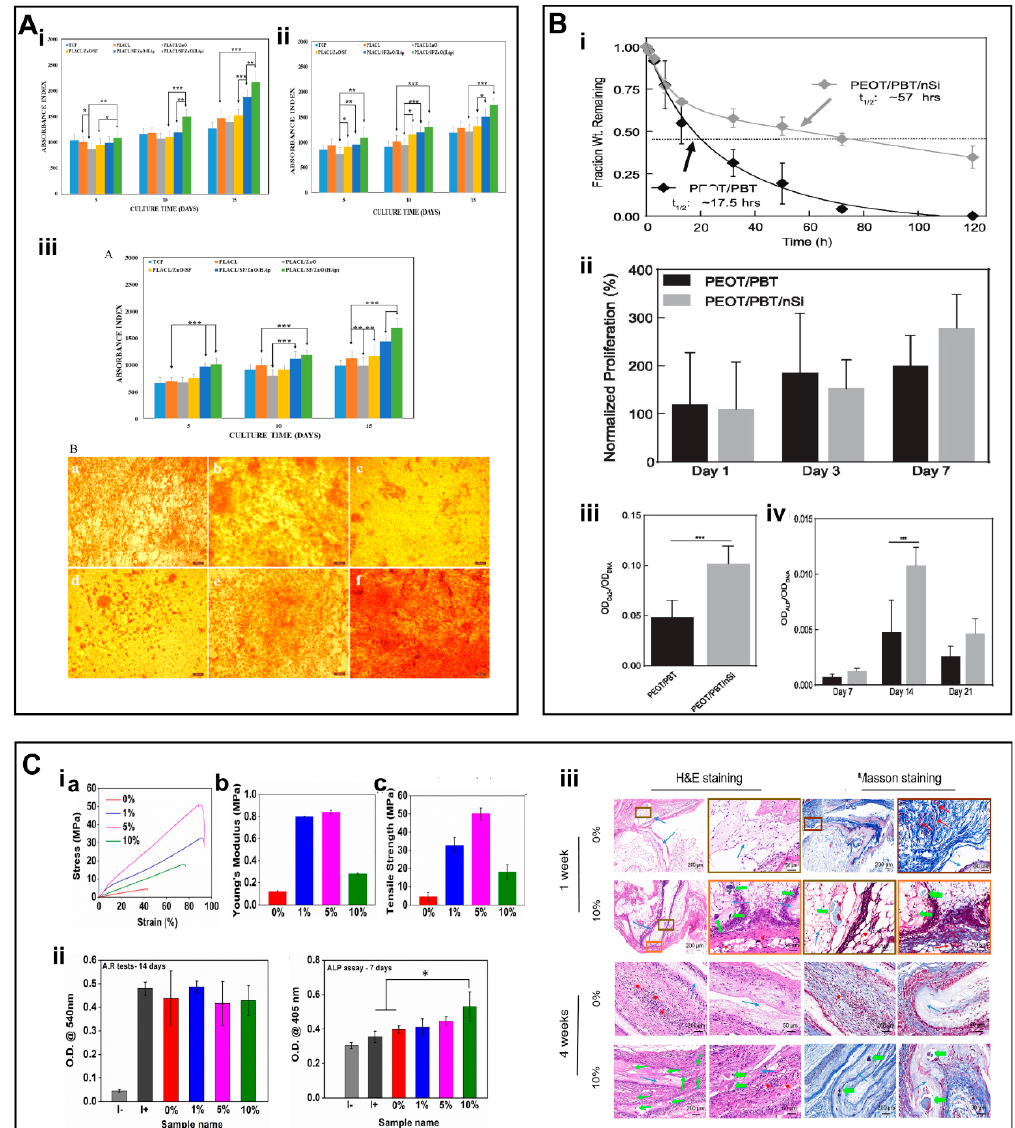
Figure 6. ( A ) (i) Proliferation of hFOB cultured on biocomposite nanofiber scaffolds. (ii) Alkaline phosphatase activity. (iii) ARS staining on biocomposite nanofiber scaffolds to quantify mineral deposits in hFOB and mineralization of osteoblasts at day 15. ( B ) (i) The degradation properties of PEOT/PBT. (ii) Proliferation of hMSCs. (iii) ALP activity. (iv) Production of mineralized ma- trix. ( C ) (i) stress–strain curves (a) Young’s modulus (b), tensile strength (c). (ii) Semi-quantitative measurements of ARS tests and ALP assay. (iii) H&E and Masson’s trichrome staining of